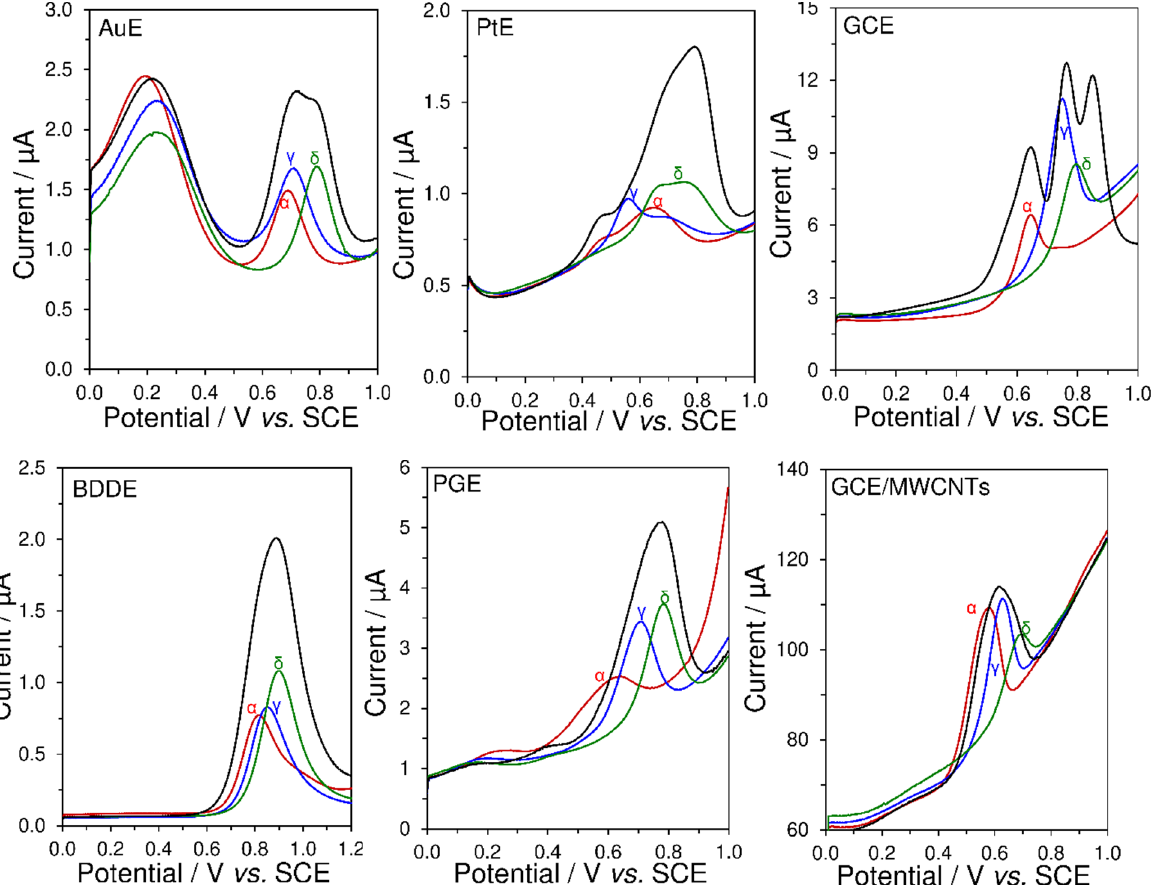
Figure 2. SWV of 50 µ mol L − 1 α -TOH, γ -TOH, and δ -TOH at different tested working electrodes. The corresponding experiments were performed in 99.9% MeCN containing 0.1 mol L − 1 LiClO 4 at E step = 5 mV, E ampl = 25 mV, and f = 20